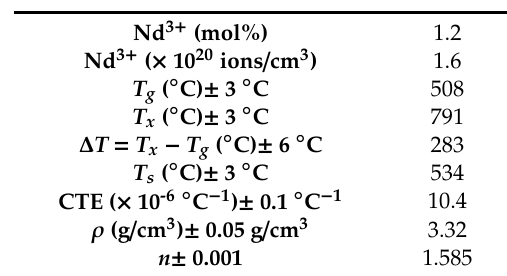
Table 2. Nd 3 + ions content in mol%, Nd 3 + ions concentration, glass transition temperature ( T g ), onset crystallization temperature ( T x ), glass stability parameter ( ∆ T ), glass softening point ( T s ), coe ffi cient of thermal expansion (CTE), density ( ρ ) and refractive index ( n ) at 633 nm of the ad-hoc synthesized Nd-doped phosphate